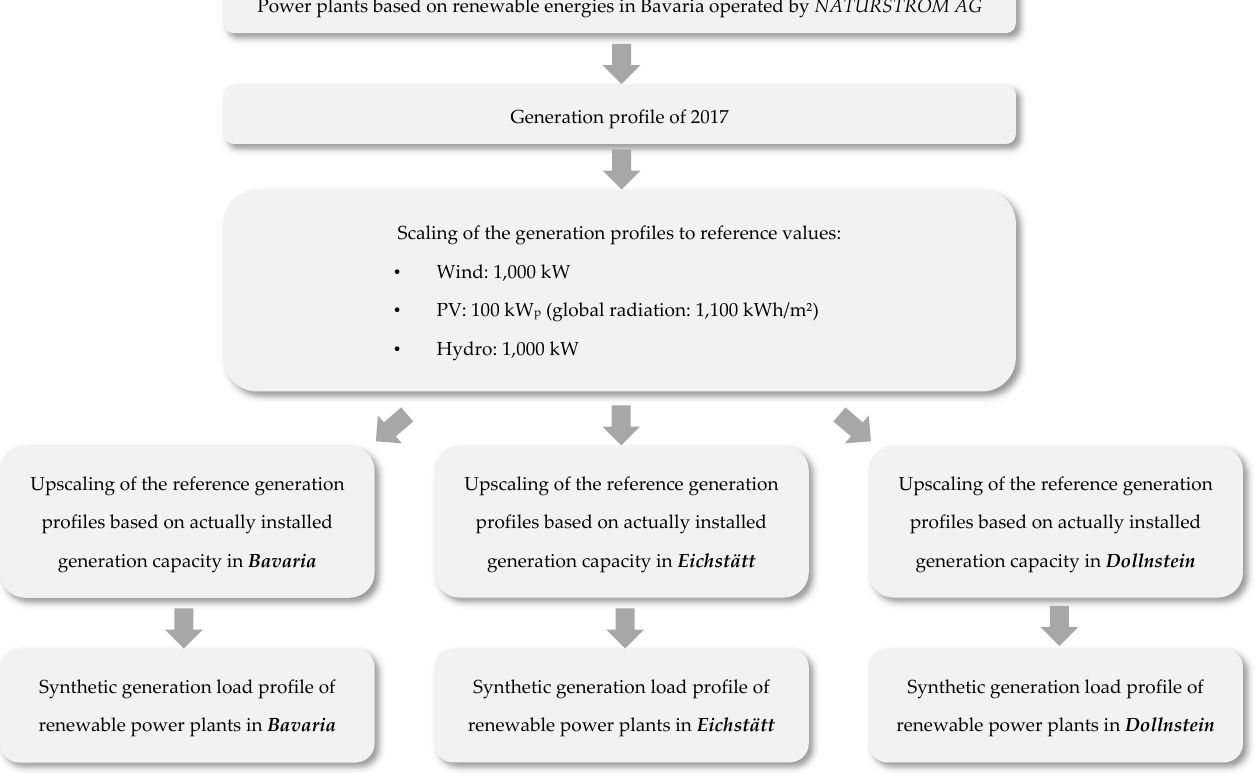
Figure 1. Methodology to develop synthetic generation profiles of renewable power plants based on measurement data of Naturstrom AG .